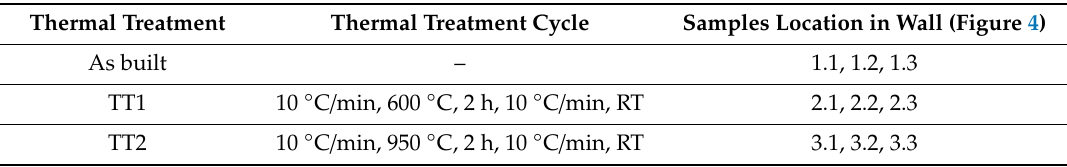
Table 3. Thermal treatments performed on the two sets of 316L tensile test specimens, for both cases of air and argon atmosphere manufacturing, along with the sample identification.